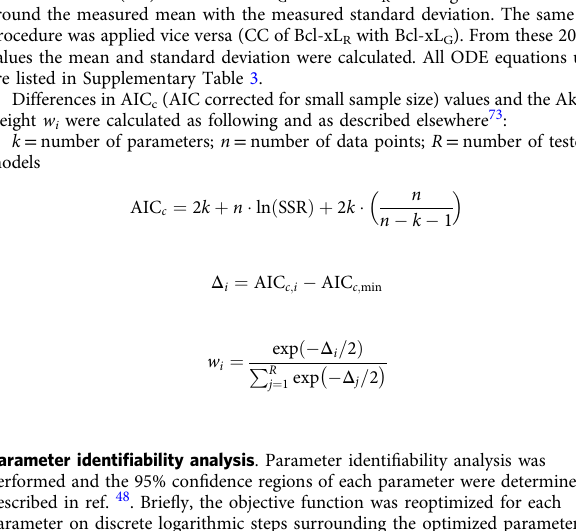
Parameter identi fi ability analysis . Parameter identi fi ability analysis was performed and the 95% con fi dence regions of each parameter were determined